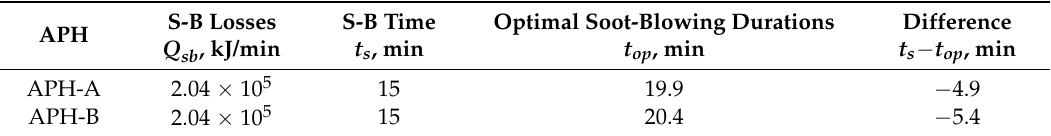
Table 5. Optimum soot-blowing durations of the